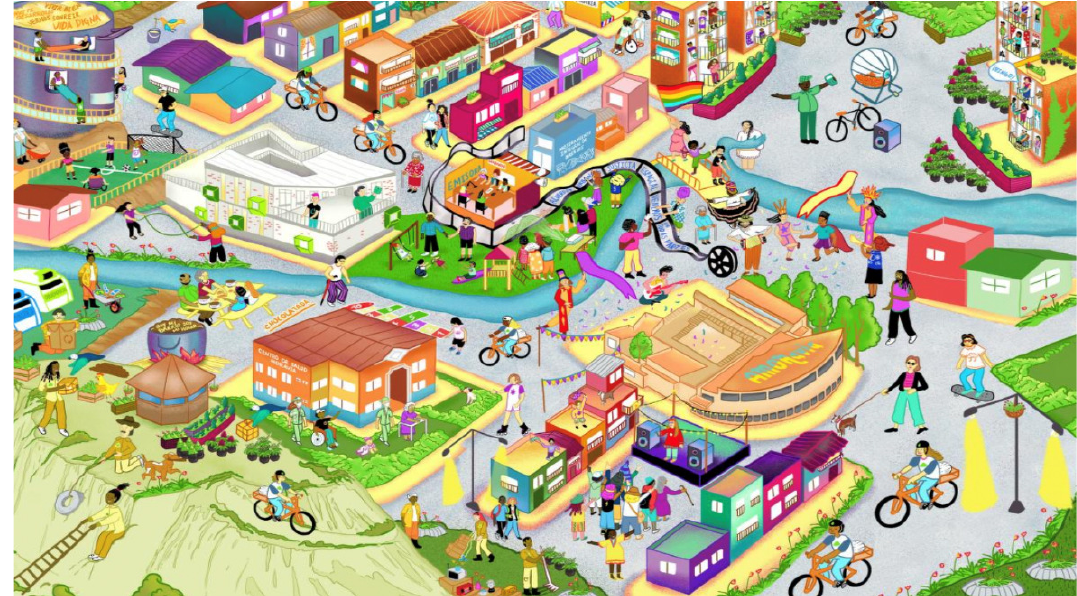
Figure 1. A re‐imagined Moravia for the living heritage atlas, drawn by Miguel Mesa for Patrimonio Vivo | Living Heritage